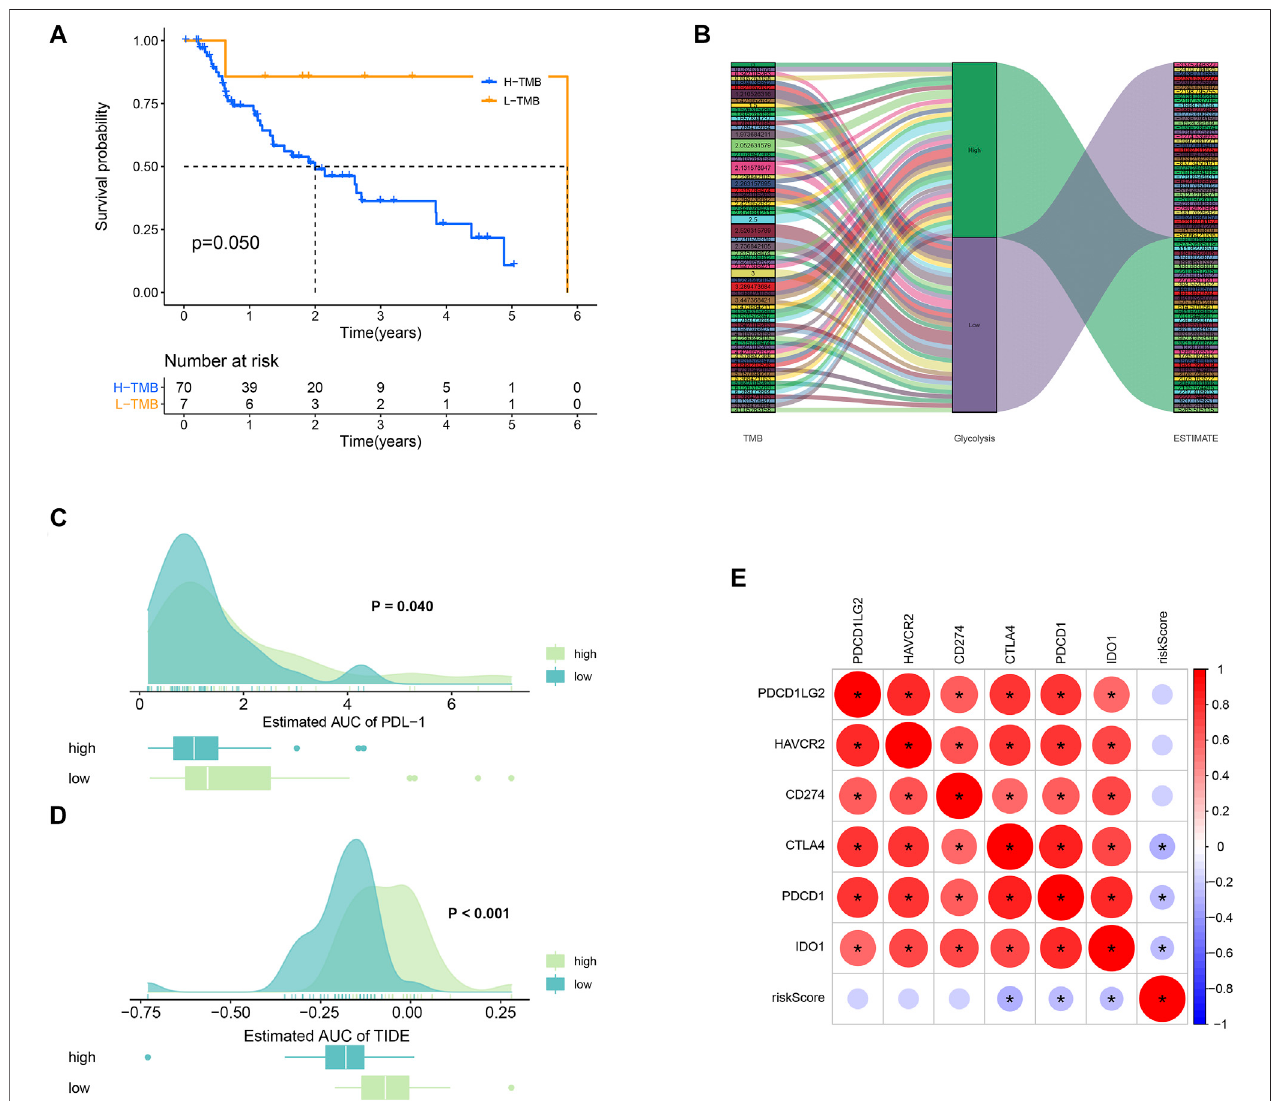
FIGURE 8 | TMB and immunotherapy response. (A) K-M survival plot. Patients with low TMB have signi fi cant probabilities to survive longer than those with high TMB. (B) Sankey diagramshowingtherelations betweenTMB, glycolysis,and theESTIMATE score. (C) PD-L1scorecomparison betweenhigh- andlow-TMB groups. (D) TIDE algorithm analysis showed that patients with high TMB had better immunotherapeutic response than those with low TMB. (E) Correlations plots between the immune checkpoints.